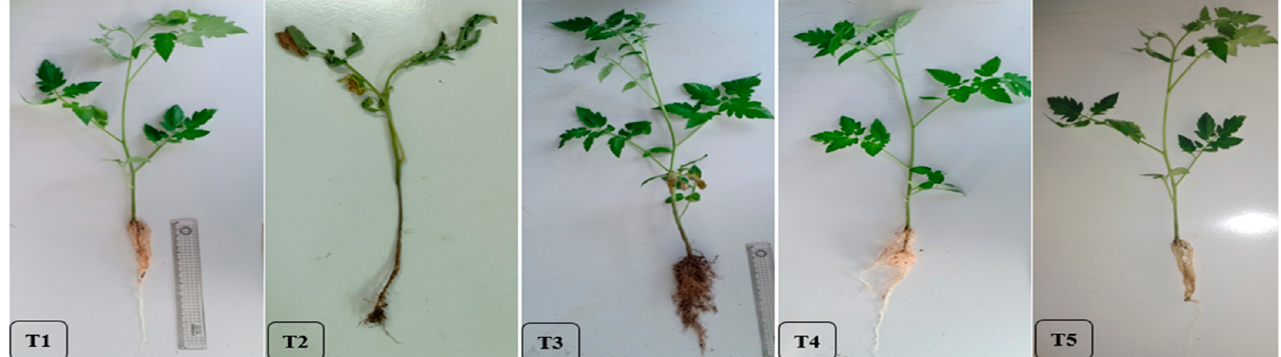
Figure 4. Effect of T. asperelloides Ta41 on R. solani Rs33 on tomato plants under controlled greenhouse conditions. T1: tomato plant control inoculated with media-free microorganisms; T2: tomato plants inoculated with R. solani only; T3: tomato plants inoculated with T. asperelloides ; T4: tomato plants inoculated with T. asperelloides 48 h before inoculation with R. solani (protective application); T5: tomato plants inoculated with T. asperelloides 48 h after inoculation with R. solani